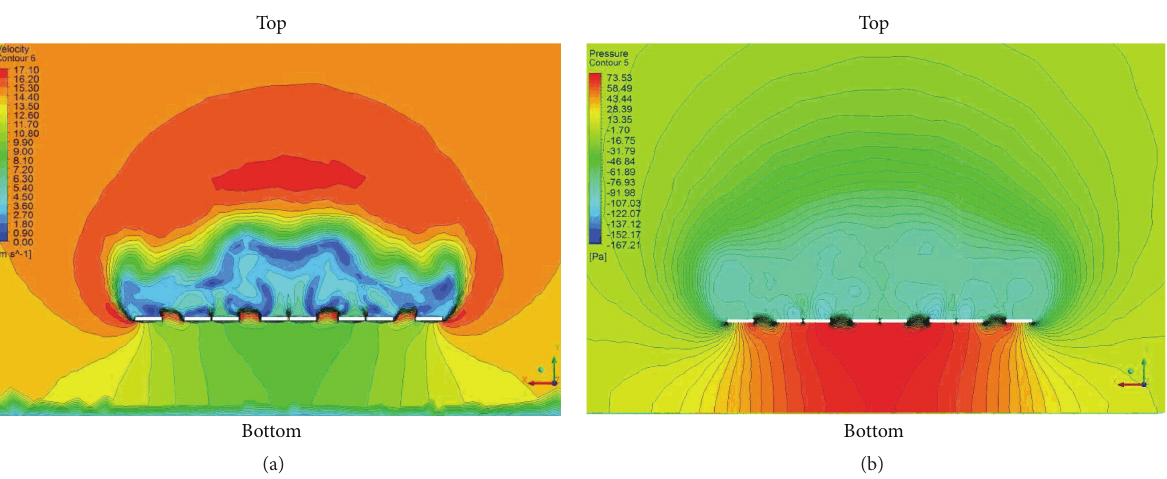
Figure 16: (a) Velocity magnitude (m/s) and (b) static pressure (N/m 2 ) contours at panels with holes, Section 2 , Figure 12, wind from bottom to